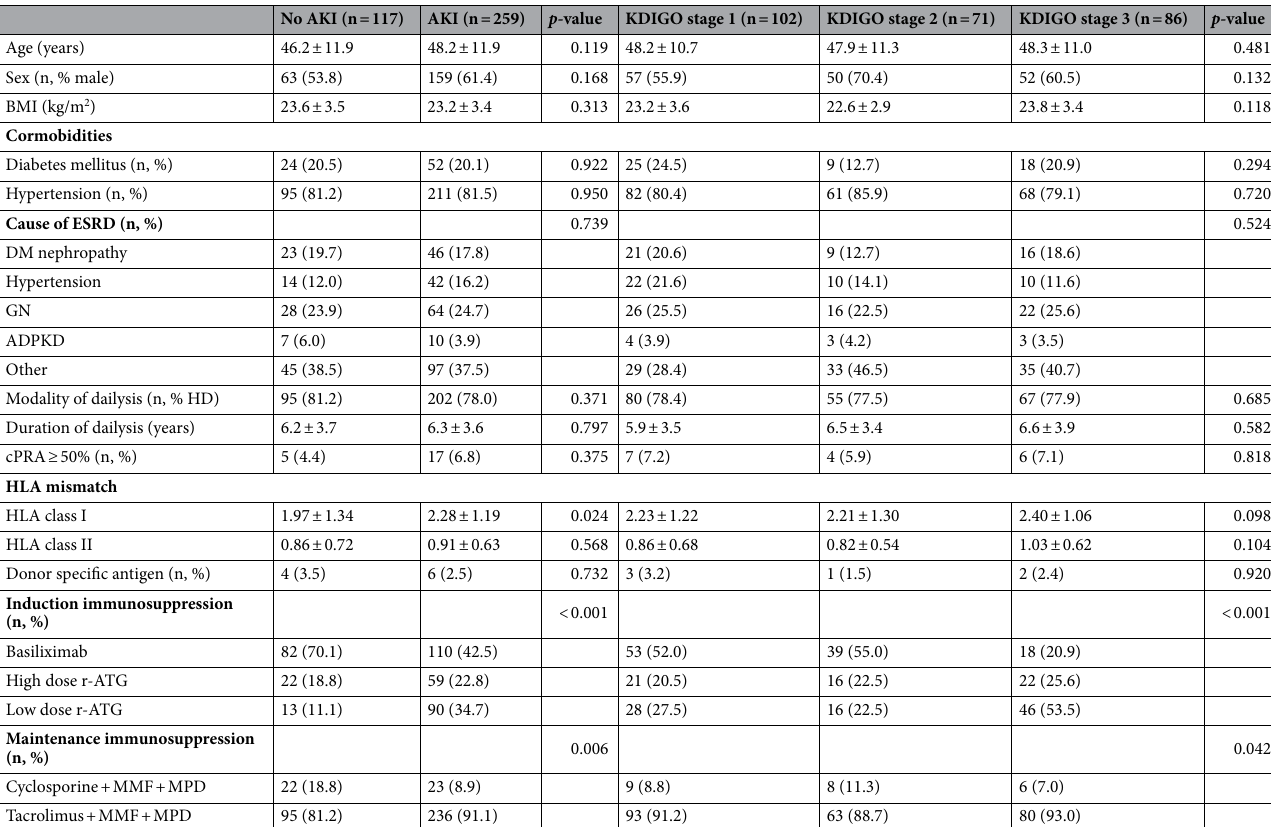
Table 2. Clinical characteristics of recipient according to AKI stage. Continuous variables given as mean ± SD. AKI acute kidney injury, KDIGO kidney disease: improving global outcomes, BMI body mass index, ESRD